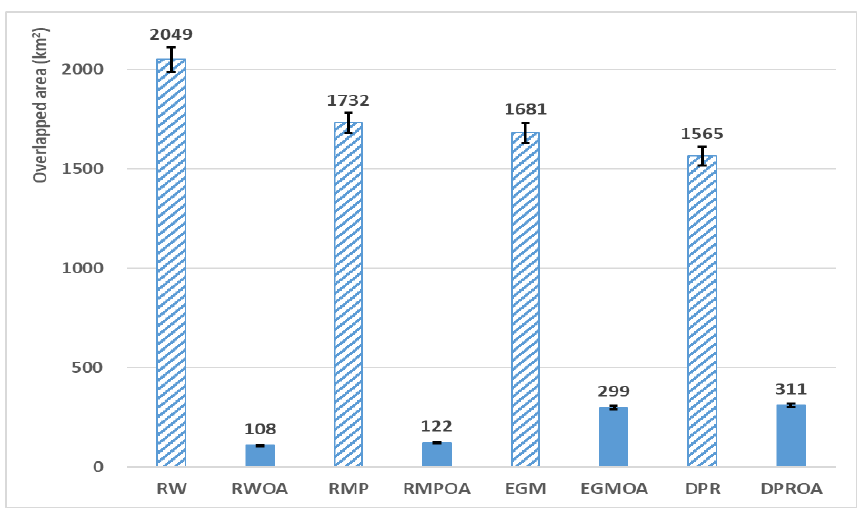
Figure 10. The result of overlapped area.